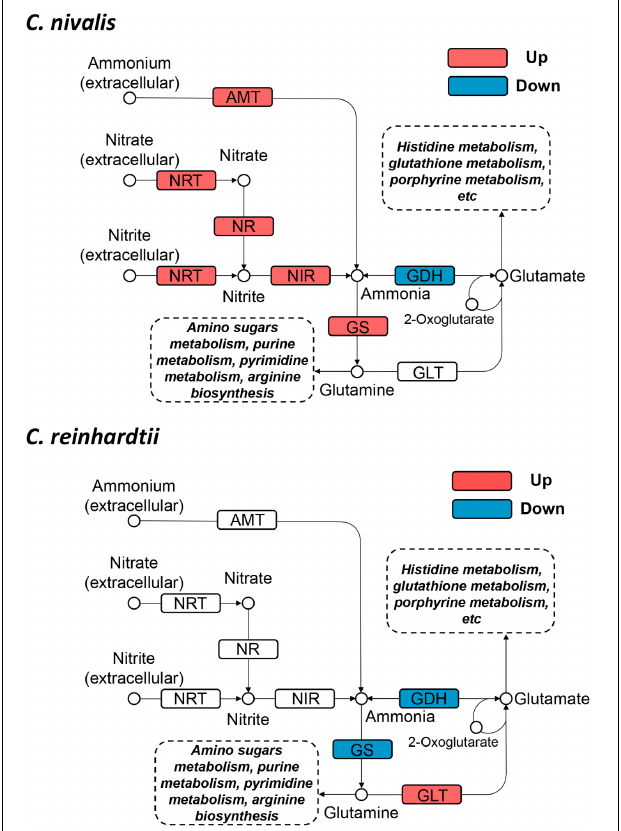
FIGURE 6 | Differentially expressed genes in nitrogen metabolism in C. nivalis and C. reinhardtii. Arrows represent the direction of reactions. Enzymes are marked by solid rectangles, and substrates and products are marked by circles. Dashed rectangles indicate pathways connected to nitrogen metabolism. Upregulated and downregulated genes are indicated by red and blue, respectively. AMT, ammonium transporter; GDH, glutamate dehydrogenase; GLT, glutamate synthase; GS, glutamine synthetase; NIR, nitrite reductase; NR, nitrate reductase; NRT, nitrate/nitrite